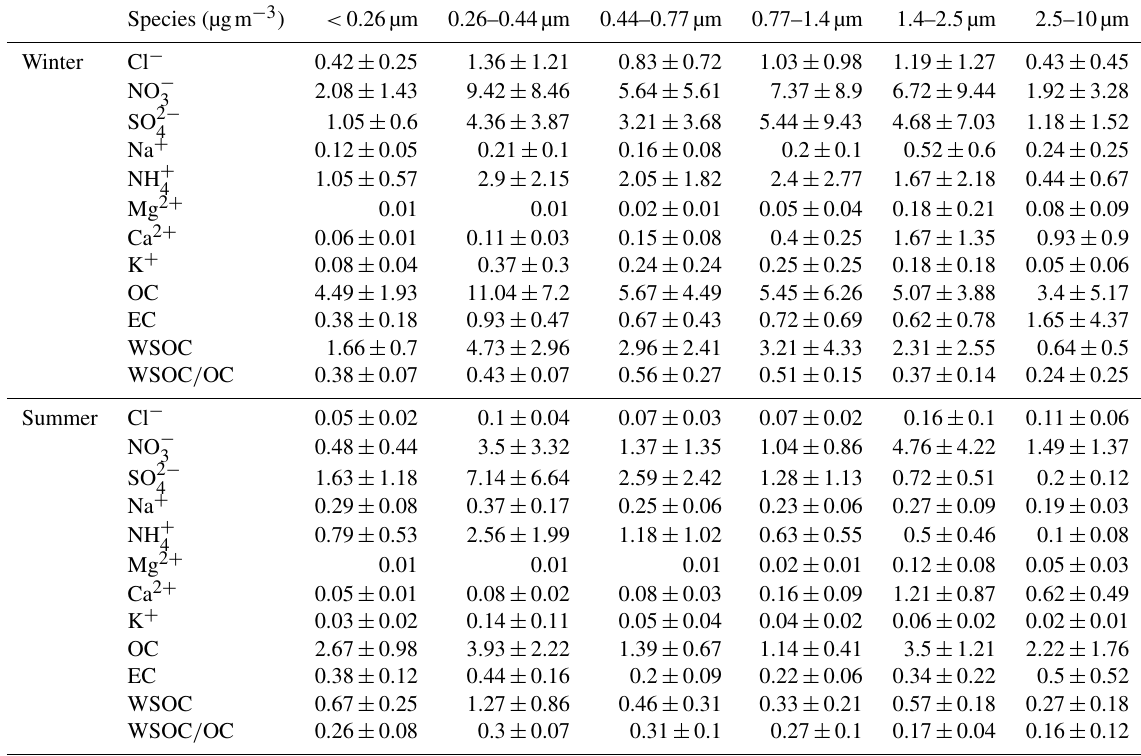
Table 1. Size-segregated average WSOC and WSIN concentrations as well as their standard